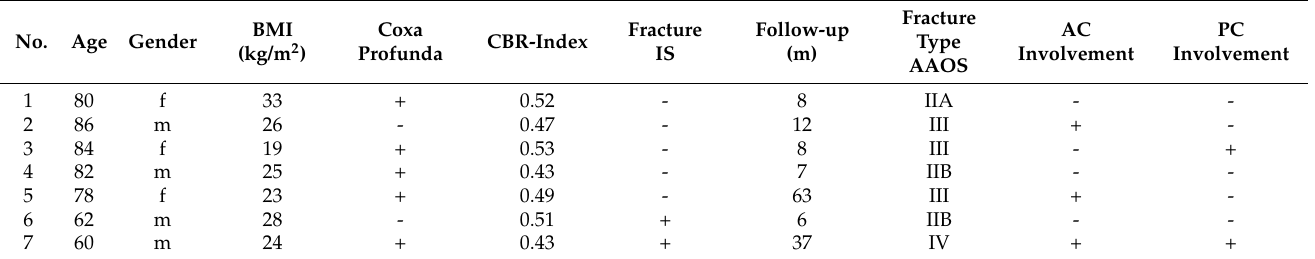
Table 1. Baseline characteristics of the study